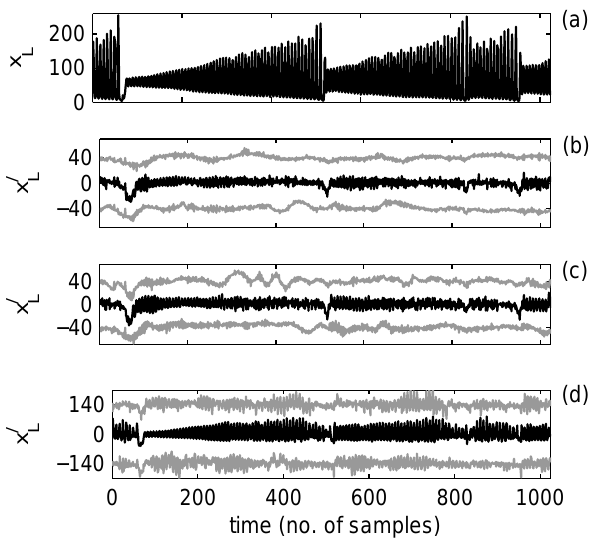
Fig. 6. x L is shown in (a) , while (b–d) illustrate the difference (in- dicated by a prime) between this time series and various surrogates series at 3 choices for ρ (0.97 in 6b, 0.95 in 6c, and 0.50 in 6d). The black line in these cases represents x L − x F , where x F is a data series produced solely from the fixed wavelet coefficients. The grey lines show x L x s where the upper surrogate series maximizes A λ = 1 s at this ρ in Fig. 5, and the lower series has the median value for A λ = 1 s